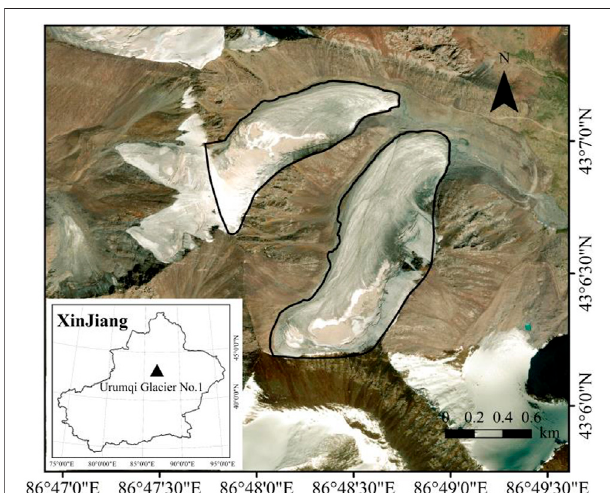
FIGURE 1 | Geographic location of Urumqi Glacier No. 1, Tianshan mountain,andtheblacktriangleinthemapofXinjiangindicatedthelocationof the study area. The image of the glacier was obtained by fi eld